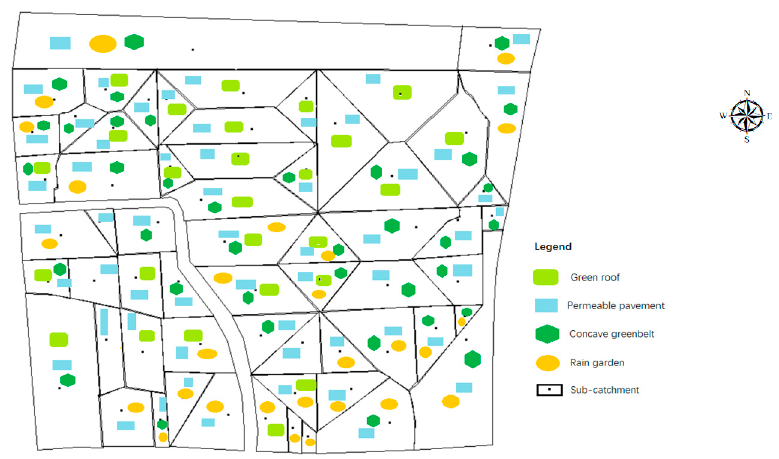
Figure 3. The distribution of each low-impact development (LID) facility (the scale is about 1:30000). Table 5. The proportions of low-impact development (LID) facilities in the four scenarios. Scenario Green Roof Permeable Pavement Concave Greenbelt Rain Garden